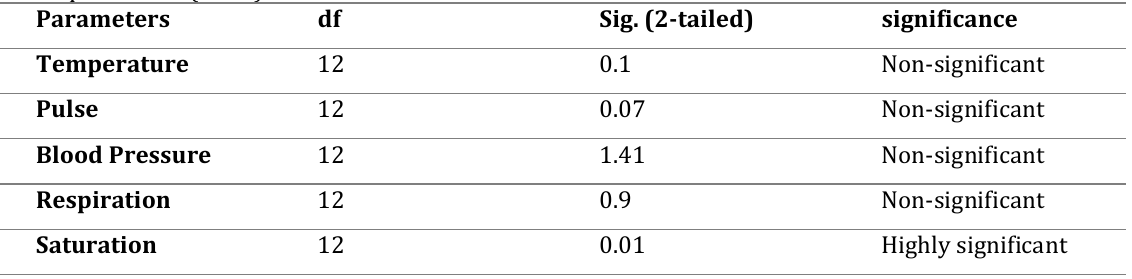
Table 5: Association of hemodynamic profile (vital signs) of the participants who required NIV or who did not required NIV.